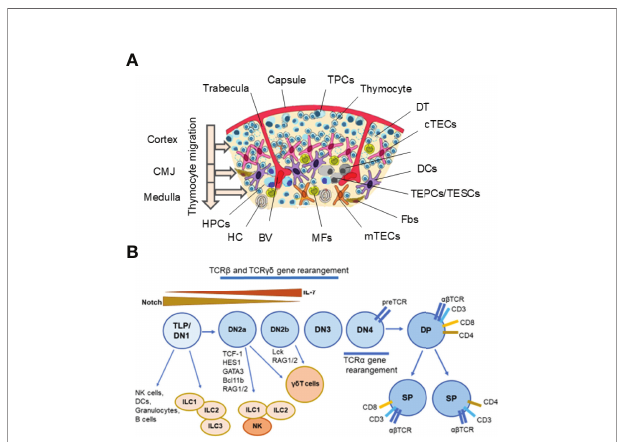
FIGURE 1 | Thymus cell architecture (A) , and T cell and innate lymphoid cell (ILC) development in the thymus (B) . The thymus consists of two lobes that are separated by connective tissue strands (trabeculae) in lobules. Each thymic lobule consisted of the cortex and medulla. The cortex contains CD34 + uncommitted pluripotent hematopoietic precursor cells (HPCs) entering the thymus at the cortico-medullary junction (CMJ) and migrating to the capsule, committed double negative (DN) CD4 − CD8 − T precursor cells (TPCs) located in the subcapsular region (DN1 – DN4 stages), and immature double positive (DP) CD4 + CD8 + (Pre-DP) cortical thymocytes migrating through the cortex and CMJ to the medullar zone. The medulla contains single positive (SP) CD4 + and CD8 + naïve thymocytes migrating to the periphery after maturing. Stromal-epithelial compartment of the thymus is submitted by minor populations of EpCam + (CD326 + ) Foxn1 + bipotent thymic epithelial precursor cells/thymic epithelial stem cells (TEPCs/TESCs), and mesenchymal stem cells (MSCs) located probably into the thymic parenchyma close to the CMJ region, as well as EpCam + CD205 + cortical thymic epithelial cells (cTECs) located in the cortex and EpCam + Air + medullary thymic epithelial cells (mTECs) located in the medulla. The cortex and medulla also contain macrophages (MFs), fi broblasts (Fbs), and dendritic cells (DCs) that, together with cTECs and mTECs, participate in the differentiation, maturation, and positive and negative selection of thymocytes. T cell and ILC lineages diverge at the stages of early T precursors/double negative 1 (ETP/ DN1) and the DN2-DN3 transition stage. Depending on the status of the TCR loci, the strength of Notch signaling and activities of E-ld proteins and Bcl11b, multipotent TLPs may develop conventional ab T cells or acquire innate-like properties and give rise to thymic natural killer (NK) cells, DCs, granulocytes, B cells, one of three ILC subsets and invariant gd T cells. Resident ILC progenitors have been suggested to originate from failed T cell development and locally maintain the mature ILC pool. BV, Blood Vessel; DT, Dead Thymocytes; HC, Hassall ’ s Corpuscle. (A) modi fi ed from Shichkin and Antica, 2020 (9); the article is licensed under a Creative Commons Attribution 4.0 International License. (B) modi fi ed from Shin and McNagny, 2021 (138); the article is distributed under the terms of the Creative Commons Attribution License (CC